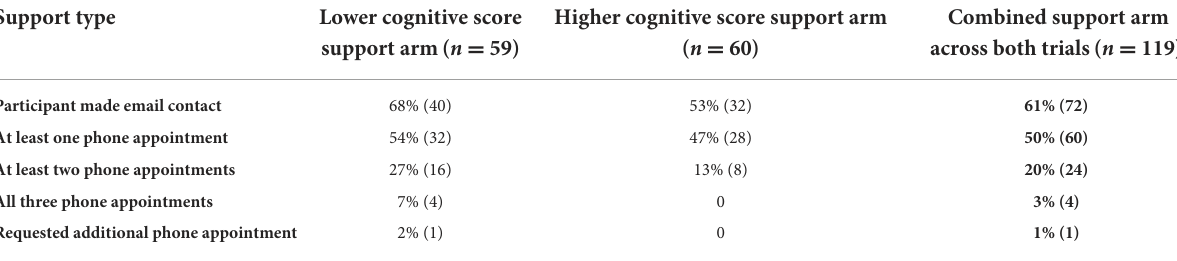
TABLE 4 Uptake and use of support provision.